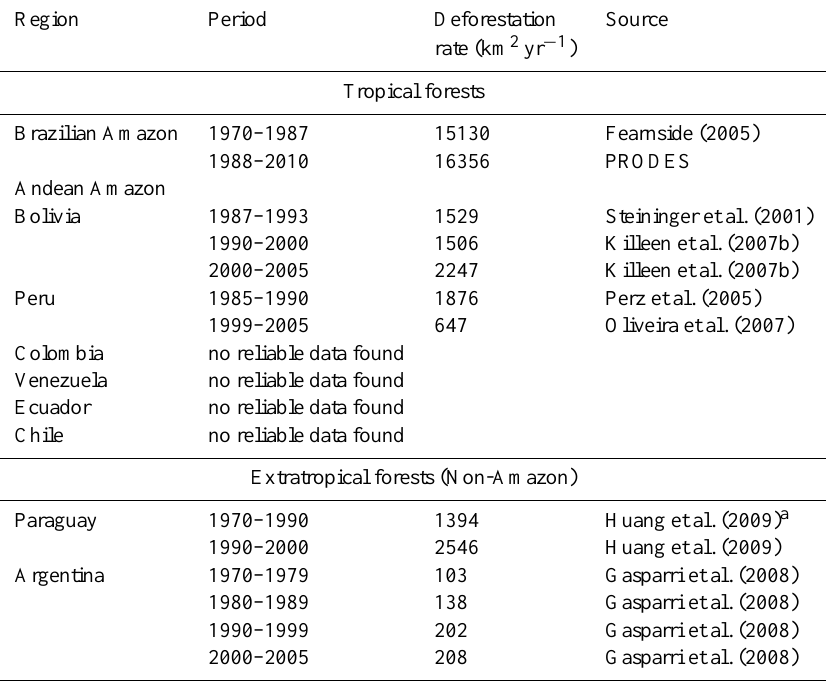
Table 7. Summary of published deforestation rates estimated mainly with remote sensing methods.